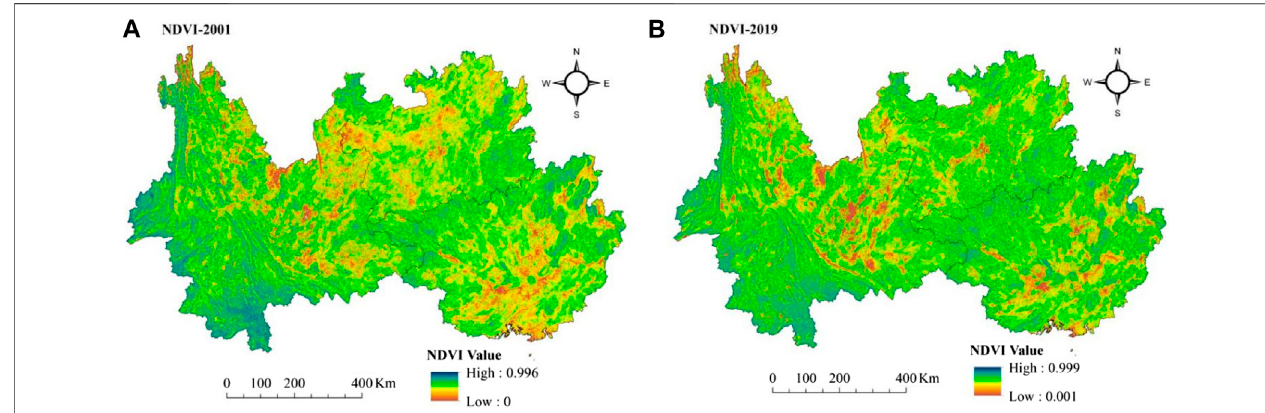
FIGURE 3 | Comparison of NDVI in the three karst provinces of southwest China between 2001 and 2019.